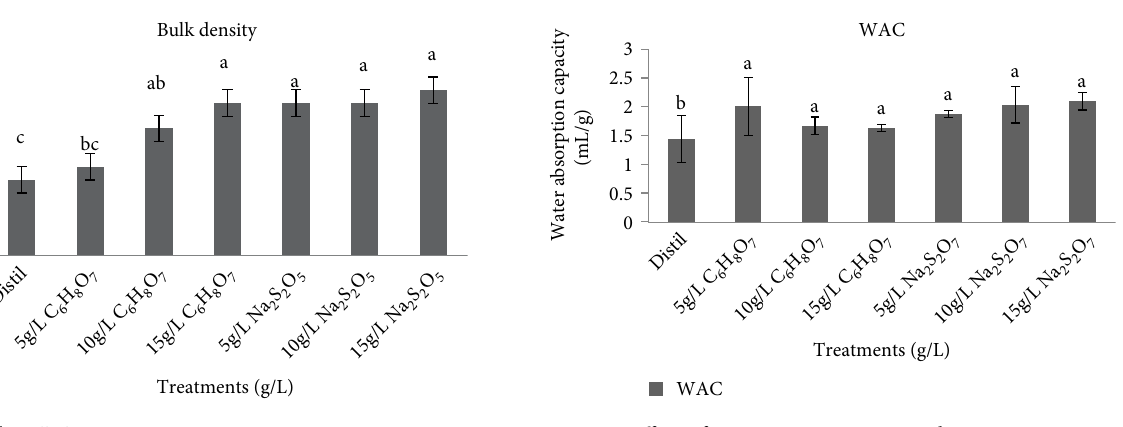
Figure 3: Effect of pretreatment on bulk density of Ndou sweet potato flour. Distil = distilled water, C sodium metabisulphite.